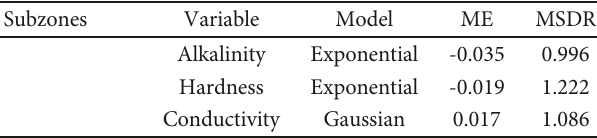
Table 2: Results of the cross-validation for the di ff erent subzones and the di ff erent